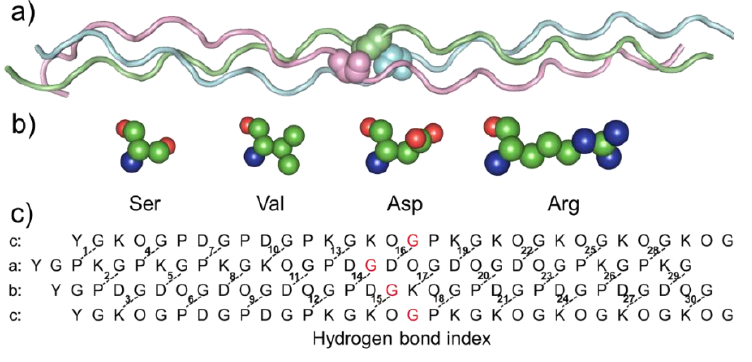
Figure 1. ( a ): Cartoon-loop diagram of abc (PDB ID:5YAN) peptide models is represented with the N-terminal at the left. The mutation residue is shown in spheres; ( b ) sphere model of mutant amino acid; ( c ) sequence of abc and the H-bond pattern. The mutation residue is marked in red.